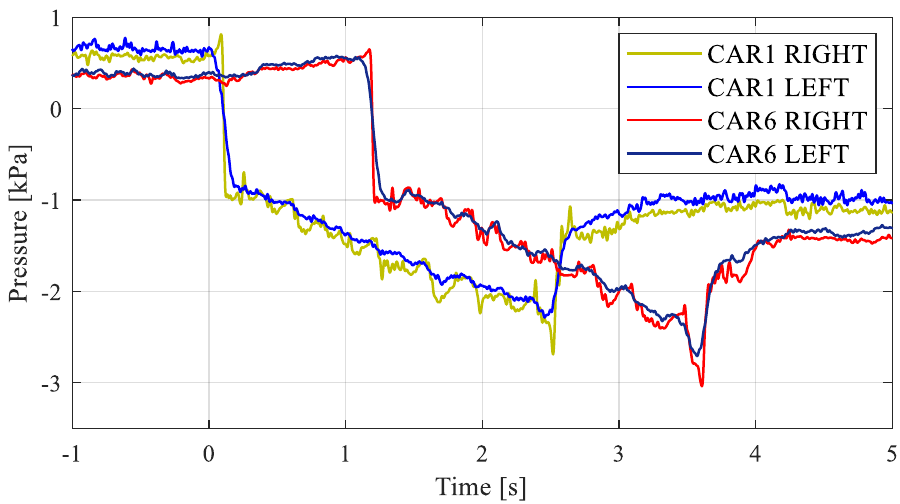
Figure 14. Comparison between the pressure acquired in di ff erent sides of the unsealed train in case of crossing within a